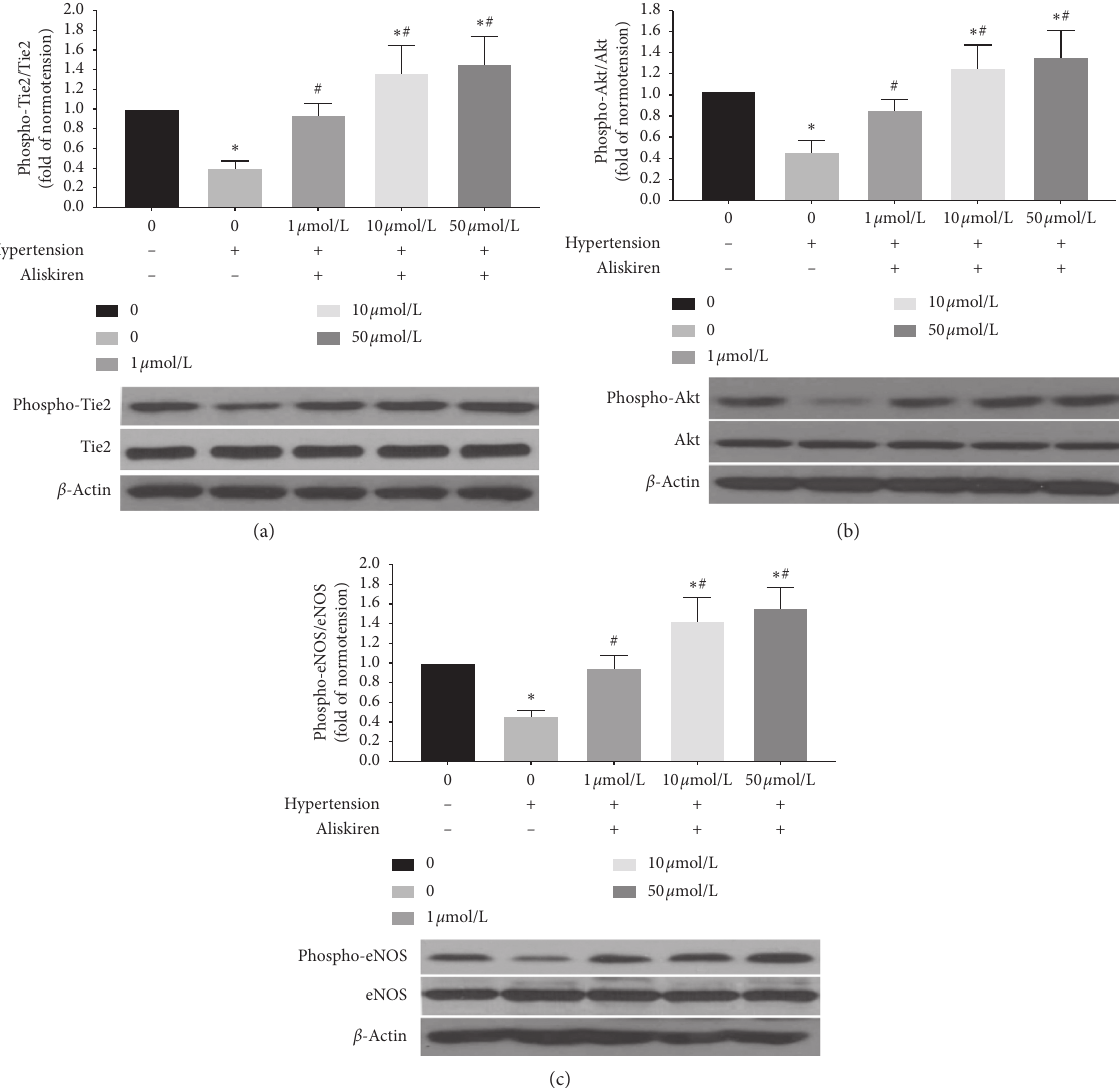
Figure 4: The quantification analysis of Tie2, Akt, and eNOS phosphorylation in patients’ EPCs treated with different concentrations of aliskiren. Quantification analysis of Tie2 (a), Akt (b), and eNOS (c) phosphorylation in patients’ EPCs treated with 1 μ mol/L, 10 μ mol/L, or 50 μ mol/L aliskiren for 12 h ( ∗ P < 0 . 05 vs. non-aliskiren-treated EPCs from normotensive subjects, n � 18; # P < 0 . 05 vs. non-aliskiren- treated EPCs from hypertensive patients, n �